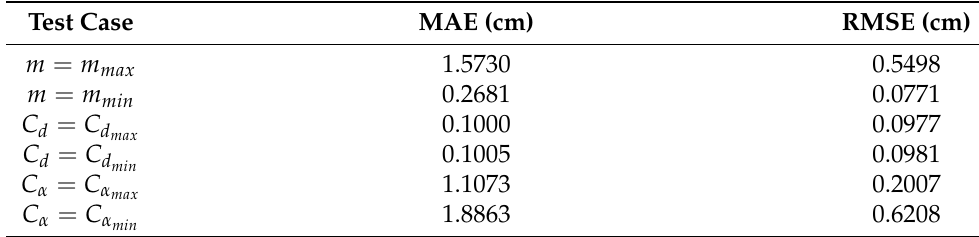
Table 8. MAE and RMSE for e 1 .